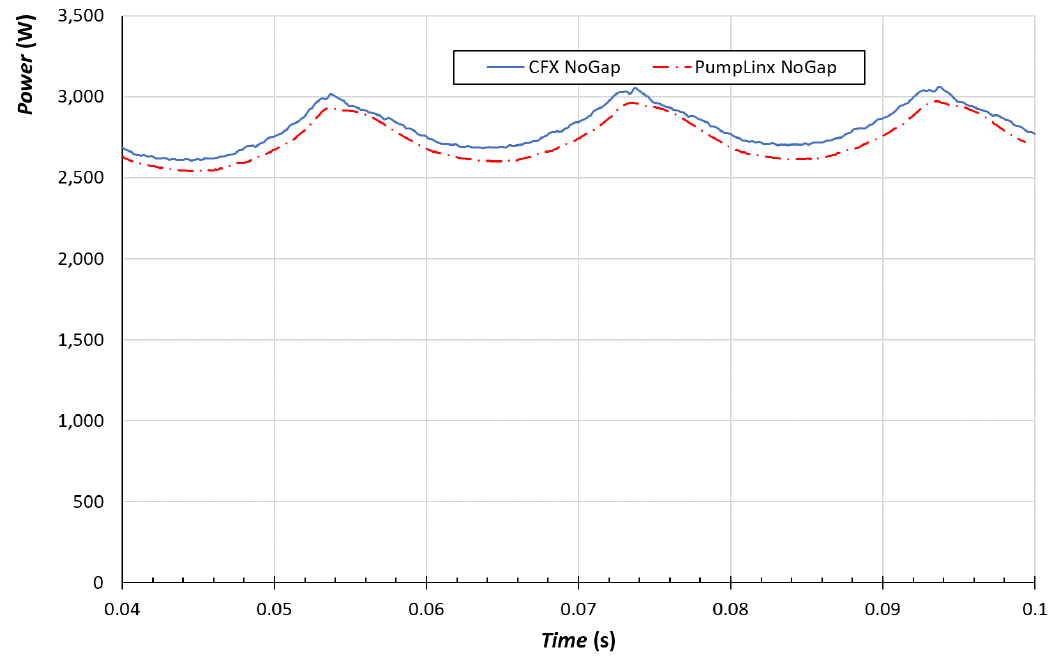
Figure 15. Comparison of power absorbed at the scroll shaft between CFX (solid line) and PumpLinx (dash-dot line).